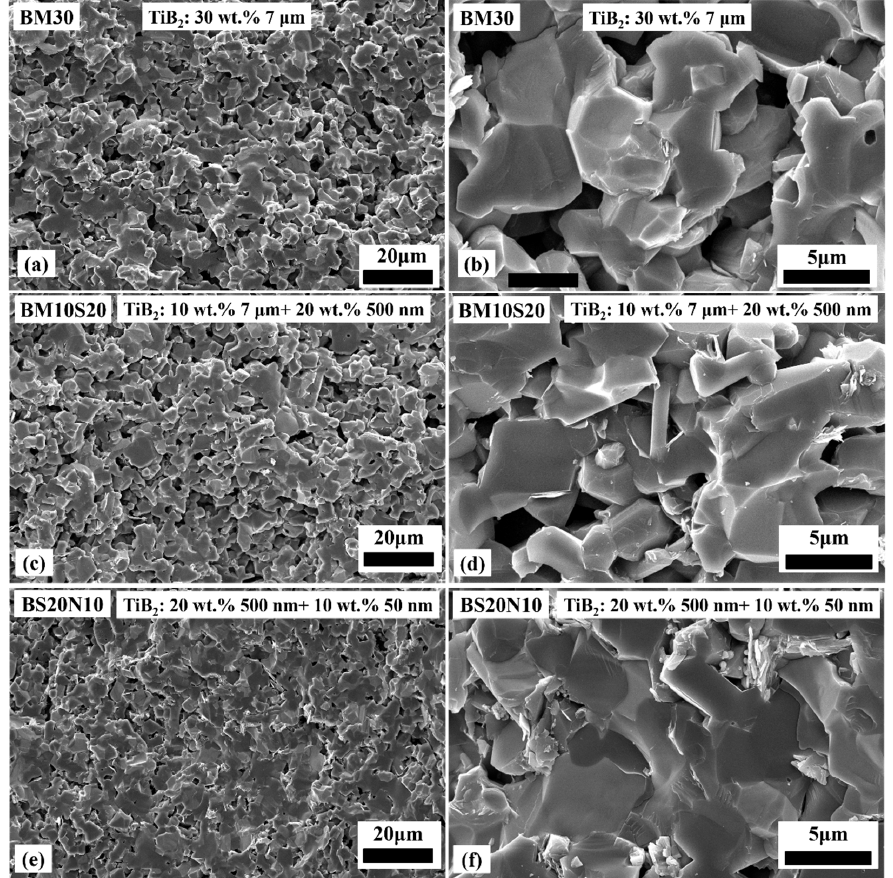
Figure 3. Fracture morphology SEM images of the B 4 C/TiB 2 ceramic composites with various TiB 2 raw powder mixtures. ( a , b ) BM30, ( c , d ) BM10S20 and ( e , f )